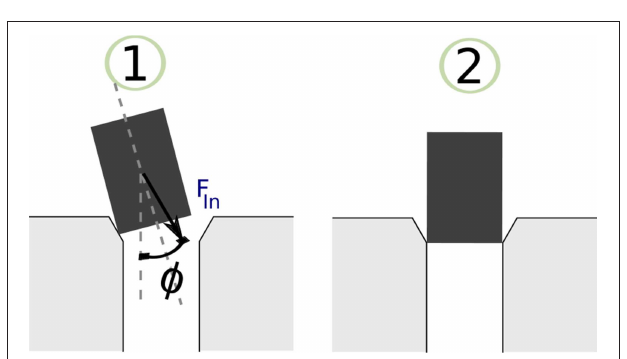
FIGURE 3 | Manual labeling of the PiH insertion process based on F z force component.